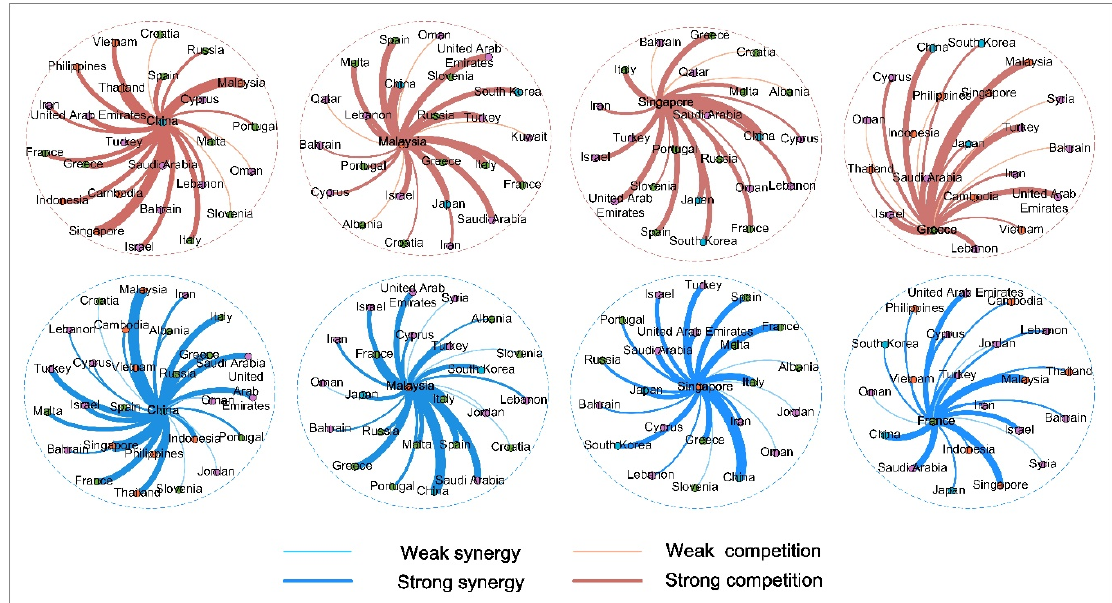
Figure 11. Interregional traffic relations in core countries. The visualization is made by Gephi. The thicker the connecting line, the stronger the relation between the two countries.